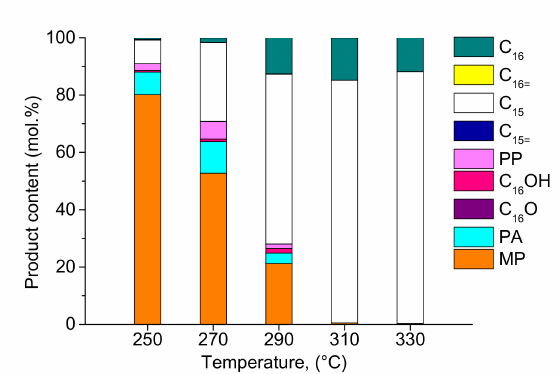
Figure 6. Effect of temperature on the composition of the liquid feed obtained in the HDO of methyl palmitate over Ni 2 P/SiO 2 – γ -Al 2 O 3 system. Reaction conditions: P H